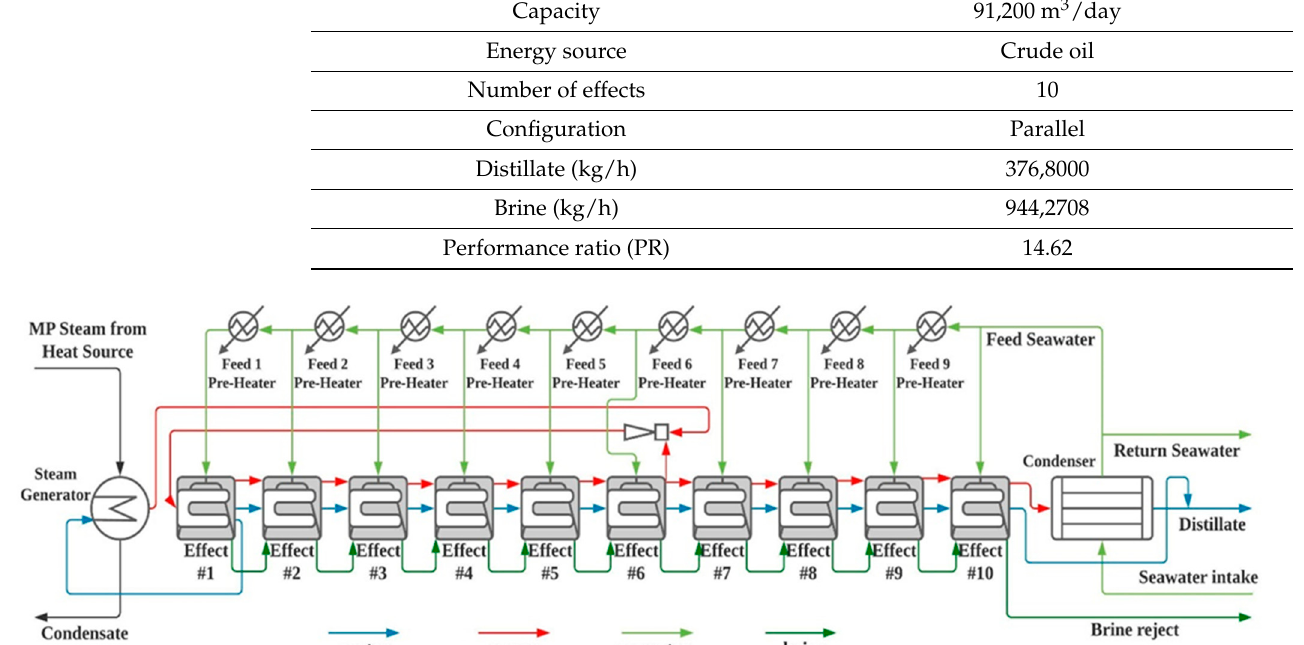
Figure 2. Schematic diagram of the existing MED-TVC. Table 1. Existing MED-TVC Desalination Plant’s Specific Information.